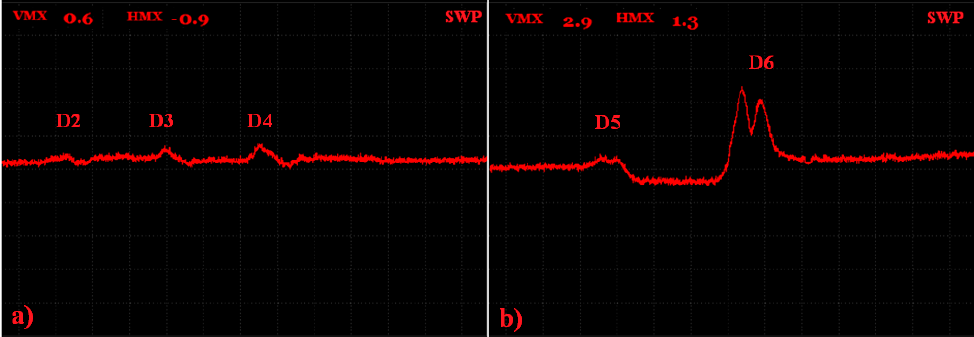
Figure 18. S5 sample, signal-to-size of defect variation; ( a ) D2–D4 defects at 50 kHz excitation frequency; ( b ) D5 and D6 defects at 15 kHz.